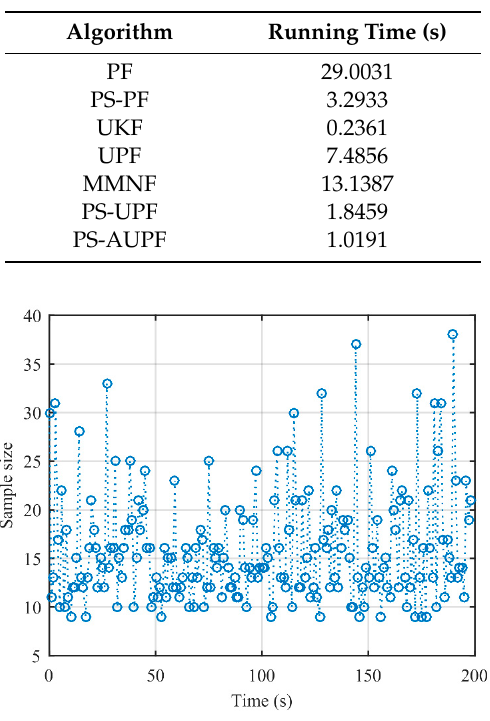
Table 5. Running time of each algorithm.